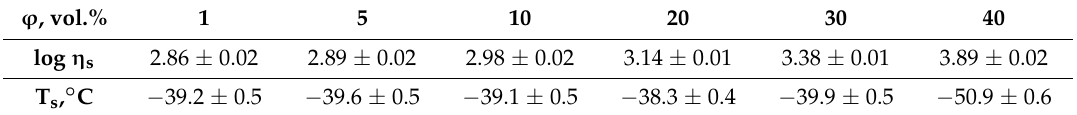
Table 2. Constants of the WLF equation for water-in-crude oil emulsions.